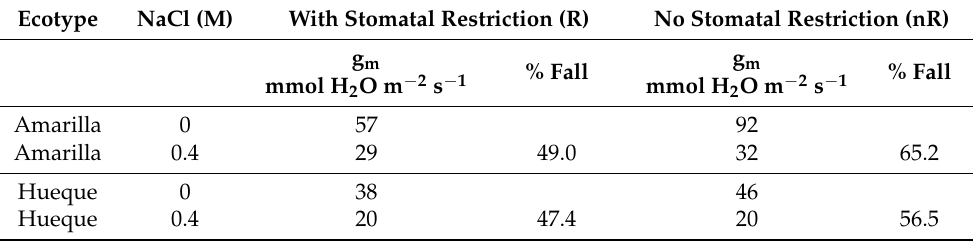
Table 7. The effect of salinity on mesophyll conductance (g m ) determined at the light saturation point, with and without stomatal